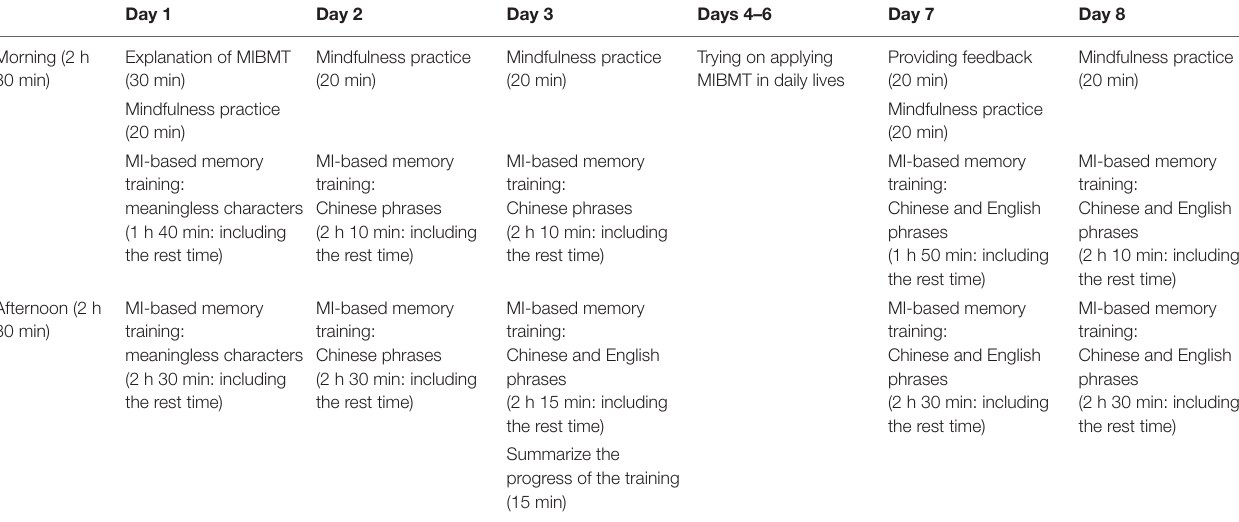
TABLE 4 | MIBMT training